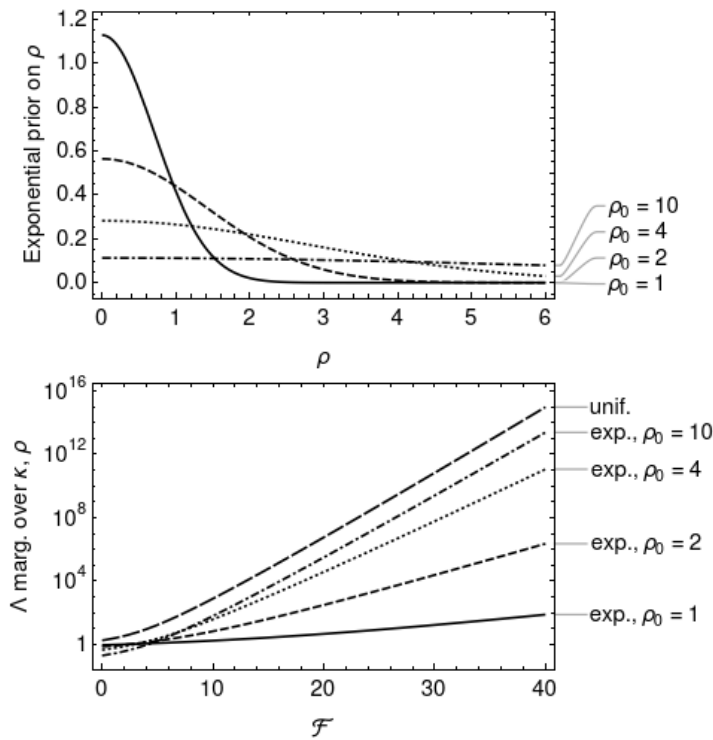
Figure 3. Top: the exponential prior on ρ (Equation (22)) as a function of ρ , for choices of the parameter ρ 0 . Bottom: the likelihood ratio marginalised over κ and ρ as a function of exponential prior on ρ (Equation (23)) for choices of ρ 0 , and with the uniform prior (Equation